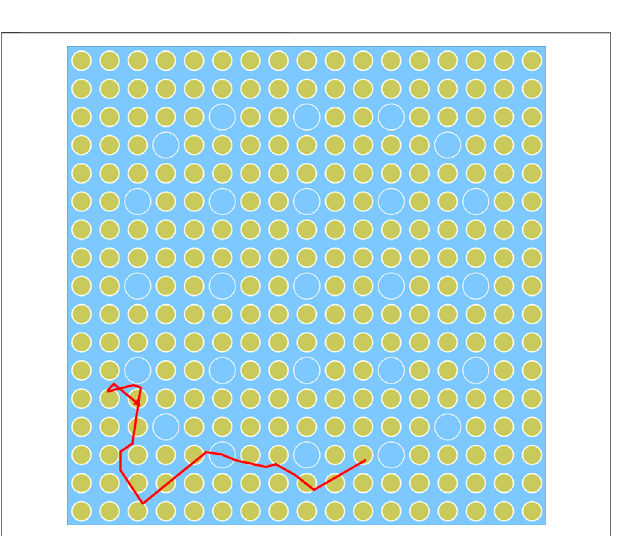
FIGURE 2 | The track of a neutron transport in a PWR assembly.